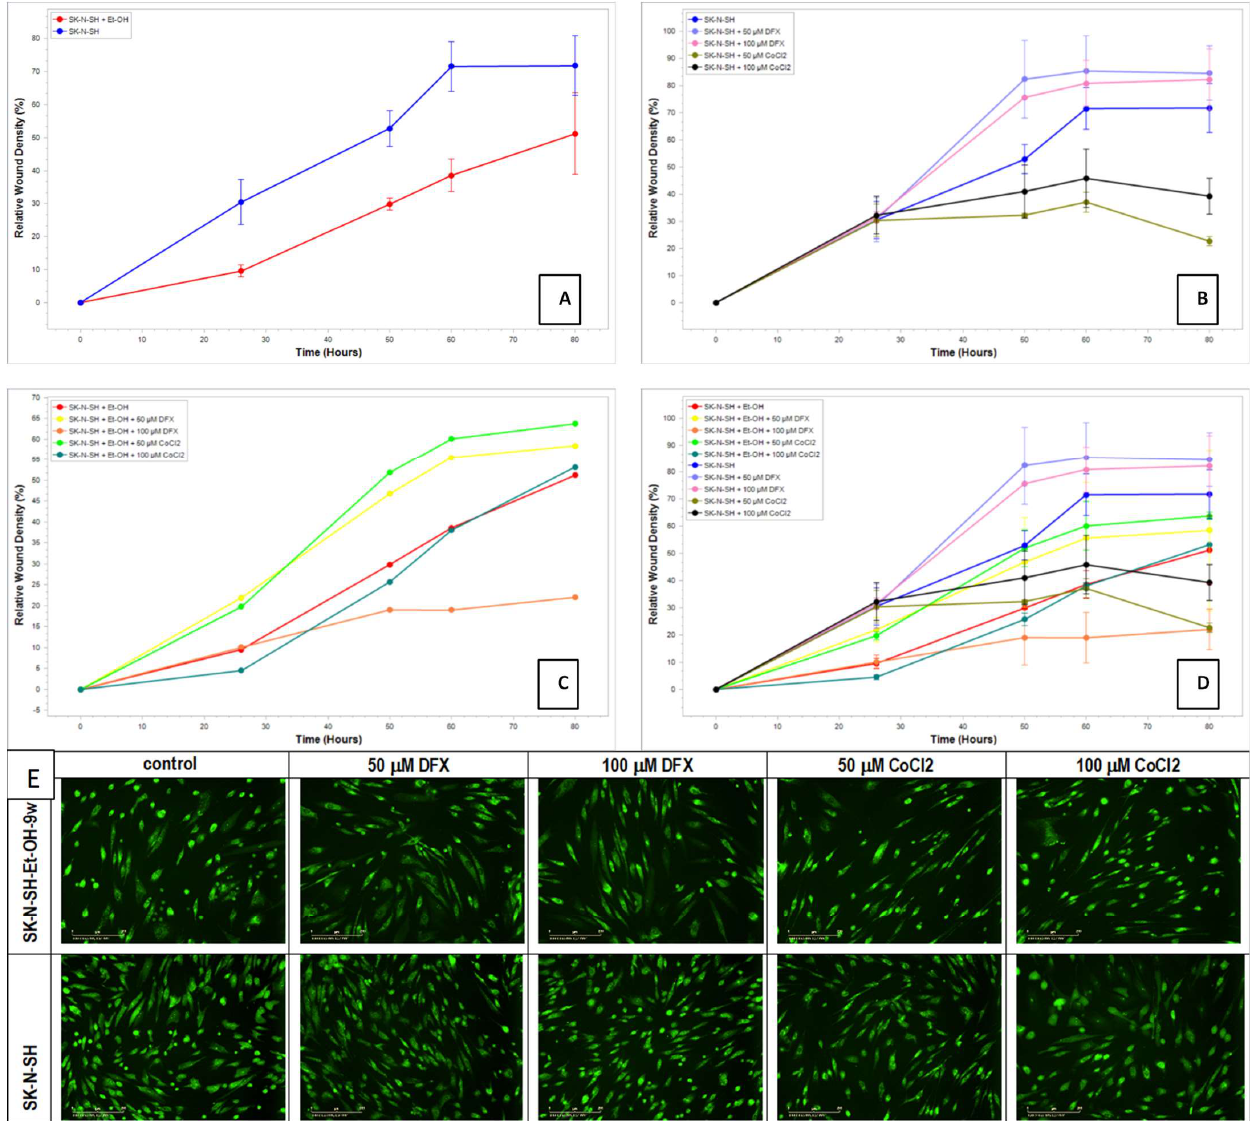
Figure 10. Summary data time courses of migration/wound healing of treated and untreated SK-N- SH cells; ( A ) SK-N-SH cells exposed or non-exposed at EtOH 50 mM for 9 weeks; ( B ) SK-N-SH cells treated post-wounding with 50 μM, respective 100 μM, DFX or CoCl 2 for 24 h; ( C ) SK-N-SH cells grown in media with 50 mM EtOH for 9 weeks and treated post-wounding with 50 μM, respective 100 μM, DFX or CoCl 2 for 24 h; ( D ) SK-N-SH cells grown in media without/with 50 mM EtOH for 9 weeks and treated post-wounding with 50 μM, respective 100 μM, DFX or CoCl 2 for 24 h; ( E ) Acri- dine Orange/Propidium Iodide Stain (fluorescence, 10× objective).